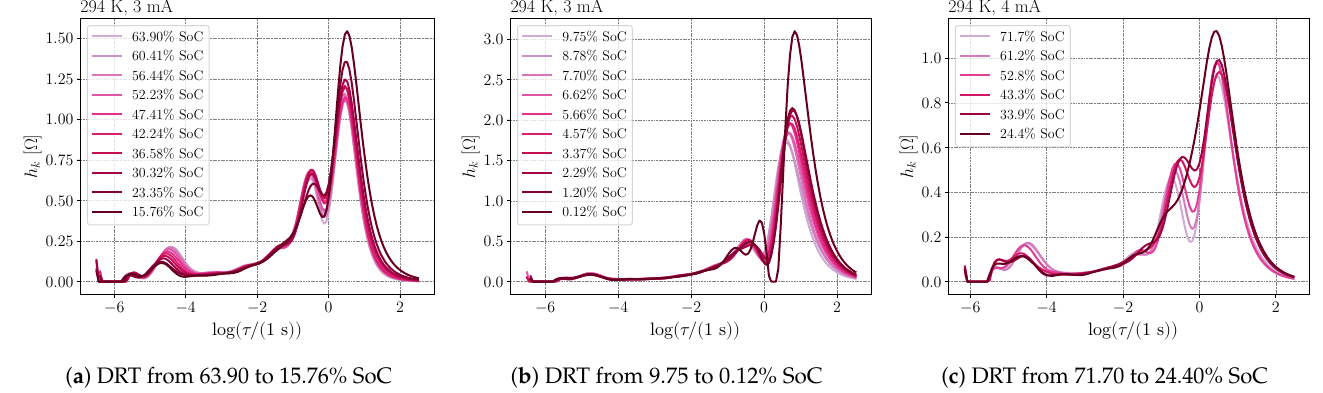
Figure 10. Process analysis of a ZAB at 294 K with ( a , b ) at 3mA and ( c ) with 4 mA discharge current. The investigated ZABs showed a temperature dependence (cf. Figure A4); however, operating phase I.1 did not seem to be affected by this dependency. Figure 11 reveals that at all temperatures the process at log ( τ ) 3 in operating phase I.1 appeared. The shape of ≈ − the DRT differed marginally between the temperatures of 273 K and 313 K, but the peaks of the two main processes, i.e., log ( τ ) 3 and log ( τ ) 1.5, showed a higher resistance ≈ − ≈ − towards the lower temperatures, as depicted in Figure 11b,c. With temperatures below 273 K, the process at log ( τ ) 3 was tremendously suppressed, showing only half the ≈ − resistance at 263 K in comparison to 273 K (see Figure 11a).